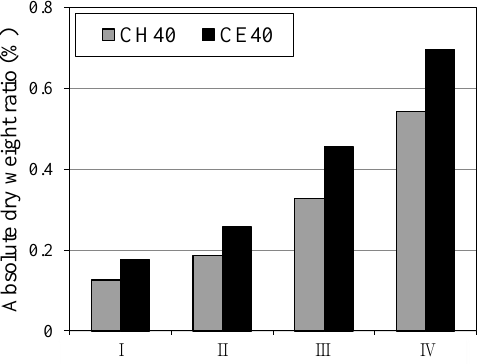
Figure 7. Absolute dry weight ratio (40 °C).